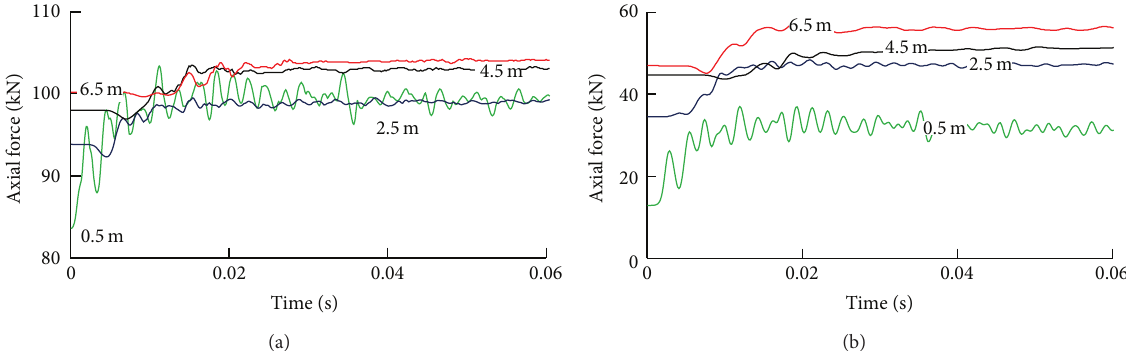
Figure 6: Evolution of the axial force in the simulated anchoring system; (a) evolution of the axial force along the free segment of bolt number 4; (b) evolution of the axial force along the anchored segment of bolt number